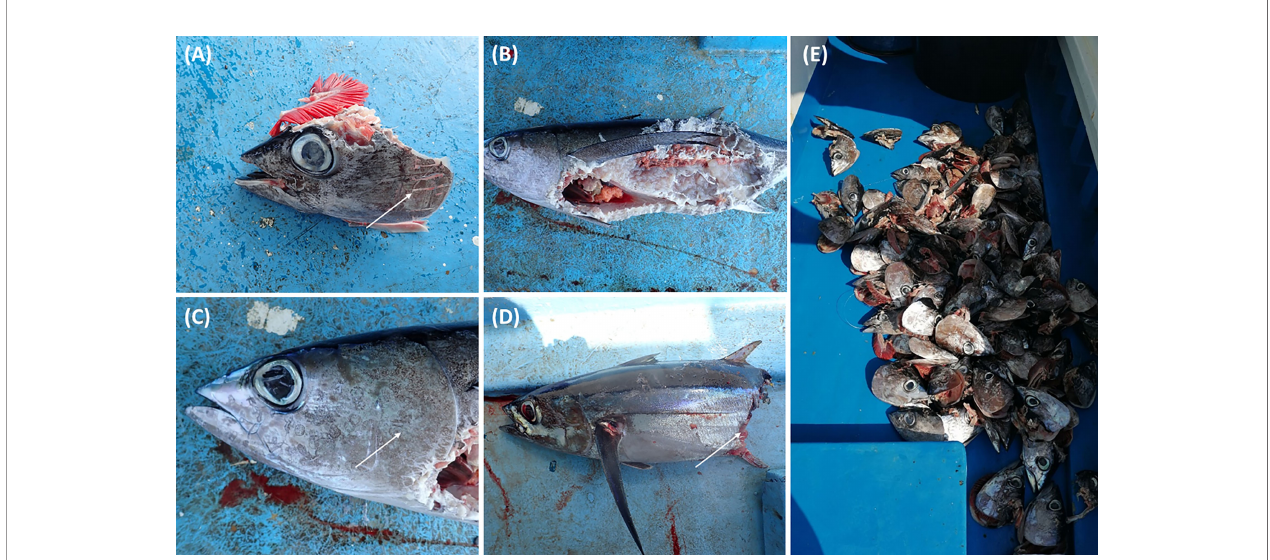
FIGURE 1 | Examples of depredated albacore tuna ( Thunnus alalunga ) by common bottlenose dolphin ( Tursiops truncatus ) ( A ; arrow shows marks odontocete tooth lacerations on head), as opposed to neon fl ying squid ( Ommastrephes bartrami ) ( B, C ; arrow shows marks of the squid suckers) and short fi n mako shark ( Isurus oxyrinchus ) ( D ; arrow indicates the sharp cut) during pelagic longline fi shing in July 2018. Depredated tunas (>200 heads) by the common bottlenose dolphin on a single fi shing trip in July 2018 (E)